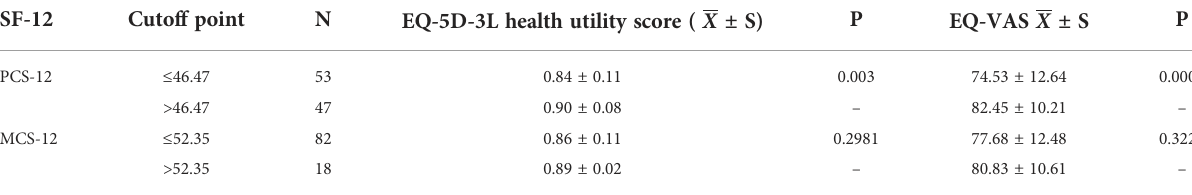
TABLE 5 Comparison of EQ-5D-3L scores by PCS-12 and MCS-12 median grouping.